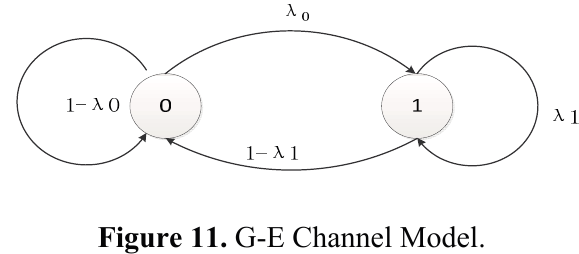
Figure 11. G-E Channel Model.